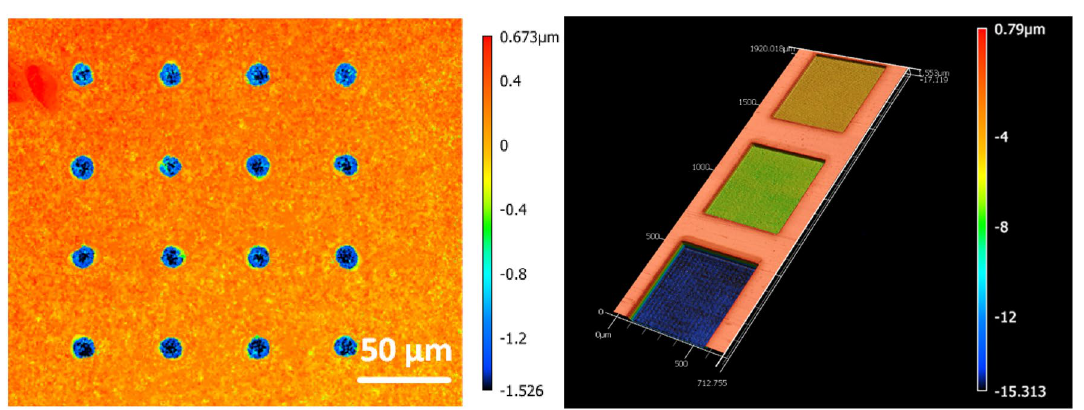
Figure 7. Laser optimization experimentation. Single-pulse experiments on plastic, for fluence and EPP investigations (left). Laser trenches on a copper substrate for repetition rate and overlap investigations